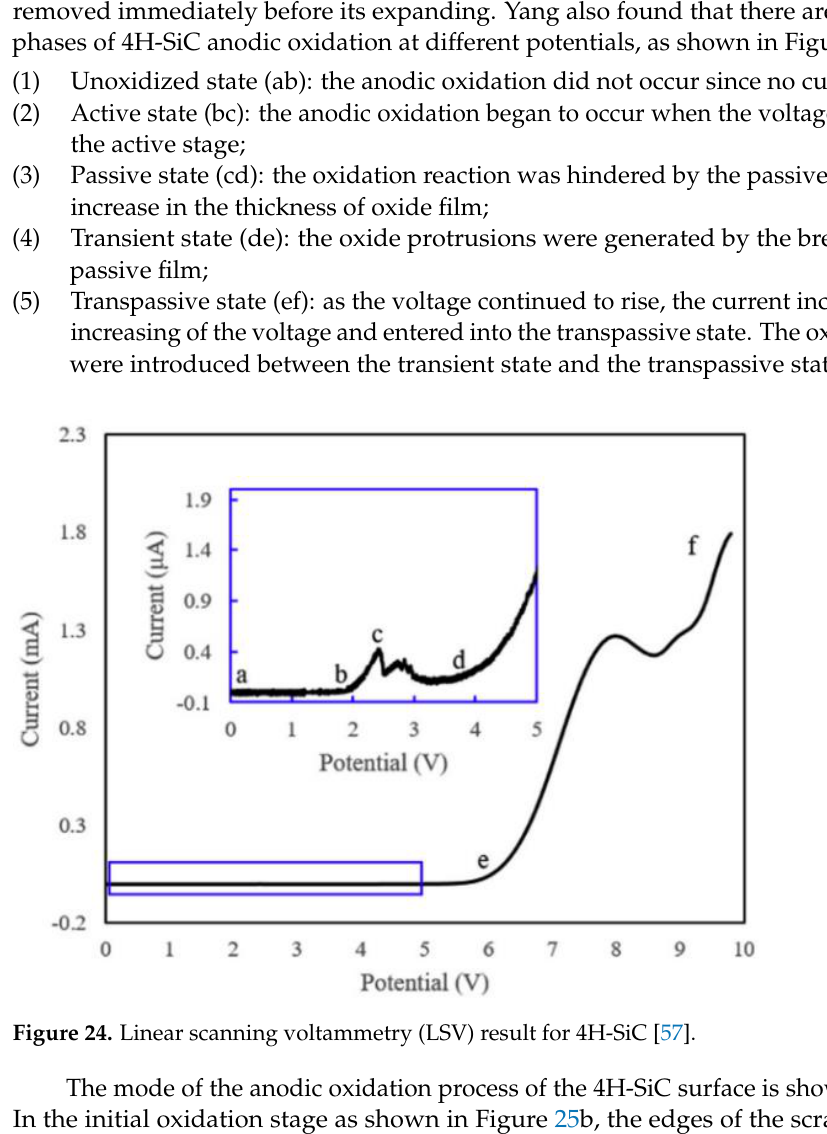
down at the atomic pits, and then the current was concentrated at the breakdown due to the low resistance, which resulted in the oxide protrusions (etching pits) as shown in Fig- ure 25c. Anodic oxidation was the oxidation of SiC by the hydroxyl group in the electro- lyte. In the initial stage, the diffusion of hydroxyl groups was not significantly hindered by the oxide protrusions with a relatively small thickness, so the longitudinal growth of